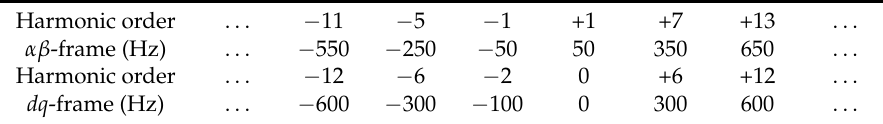
Table 2. Dominant voltage disturbances of grid voltages.